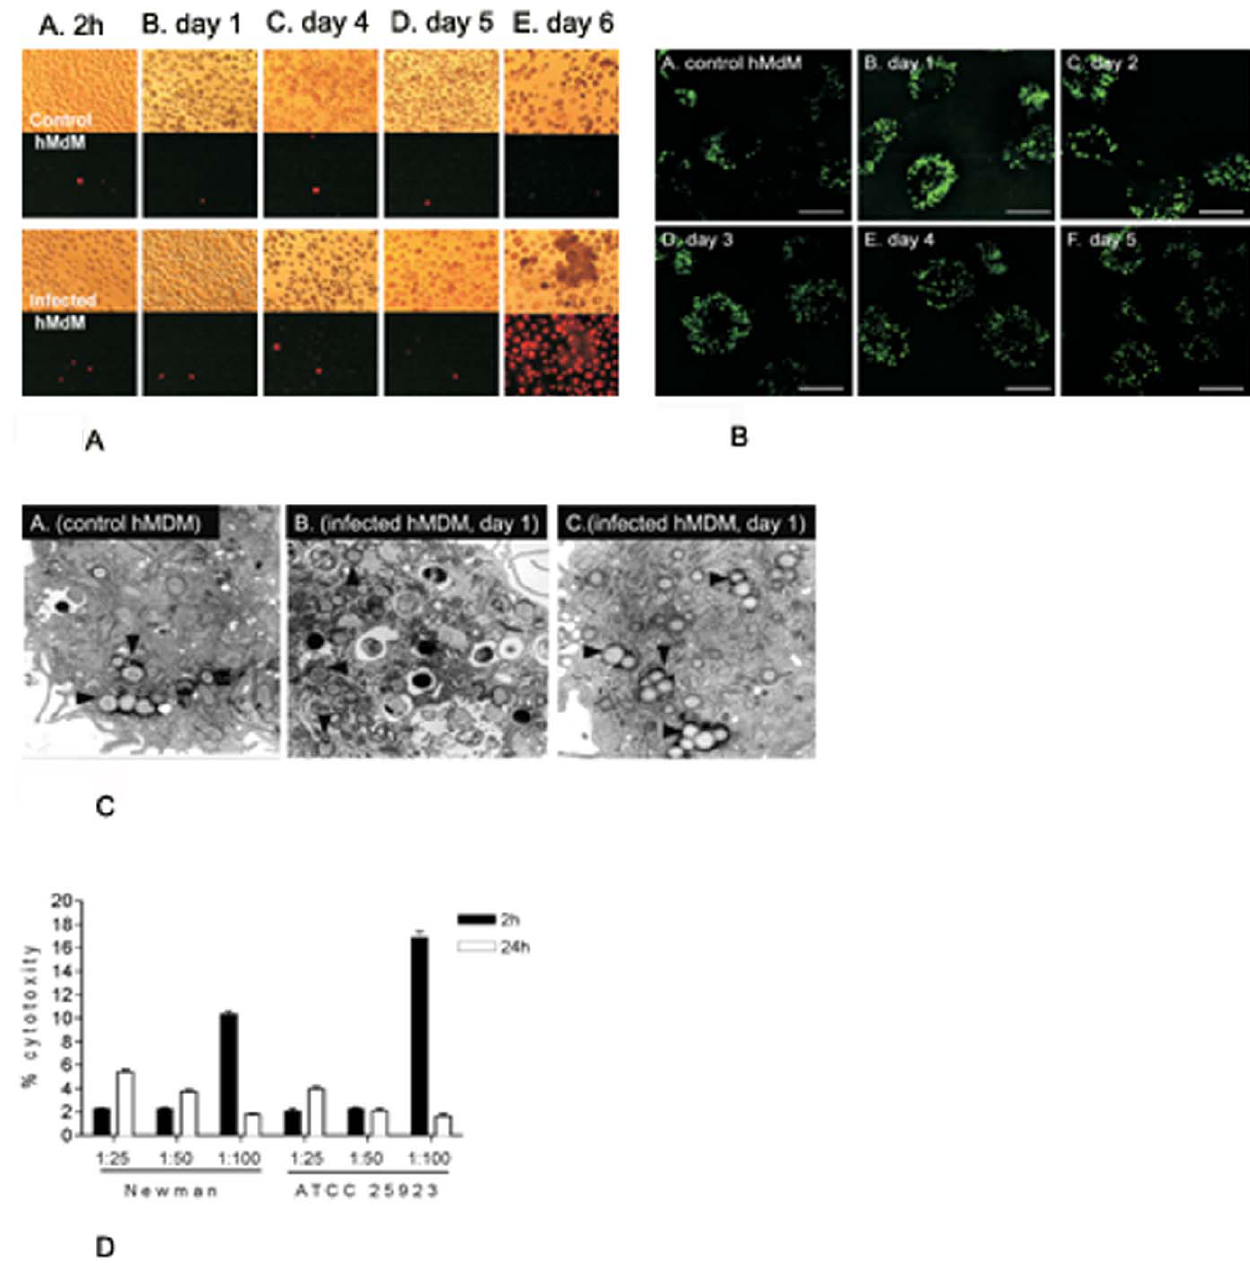
Figure 1. Internalization of S. aureus strain Newman does not affect hMDM viability until the plasma membrane is permeabilized. A. Transmission light (upper two rows) and fluorescence (lower two rows) micrographs (x 40) of control (upper panel) and S. aureus -infected cells (bottom panel) maintained in culture for 2h (A) and 1 day (B), 4- (C), 5- (D), and 6-days (E). Propidium iodide-positive cells represent infected host cells with leaky plasma membranes. B. BODIPY495/503 staining of lipid droplets of control and S. aureus infected hMDM cultures on five consecutive days post-phagocytosis. Cells were permeabilized with 0.2 % Triton X-100 and stained as described in the Materials and Methods section. All scale bars=10 m m. C. Transmission electron micrographs of control (panel A) and infected cells (panels B and C) one day post-phagocytosis. Black arrowheads point to lipid droplets. Magnification: x10,000 (A and C) and 6 7,500 (B). The photographs presented are representative of a minimum of 20 fields observed. D. Cytotoxicity (%) of S. aureus infection. Plasma membrane permeabilization or cell lysis induced in macrophage cultures by S. aureus infection at different MOI was determined as LDH activity levels. Cytotoxicity was calculated according to the formula: % cytotoxicity=[(experimental value–low control)/(high control–low control)] 6 100, where a low control is the LDH activity in the conditioned medium of the control non-infected culture, while the LDH activity in the whole cell culture with cells lysed with detergent (2% Triton X-100) constitutes a high control. An experimental value was the activity in the conditioned medium from the culture infected with S. aureus . According to this calculation the control non-infected culture was assumed to show 0% cytotoxicity. All assays were performed in triplicate.